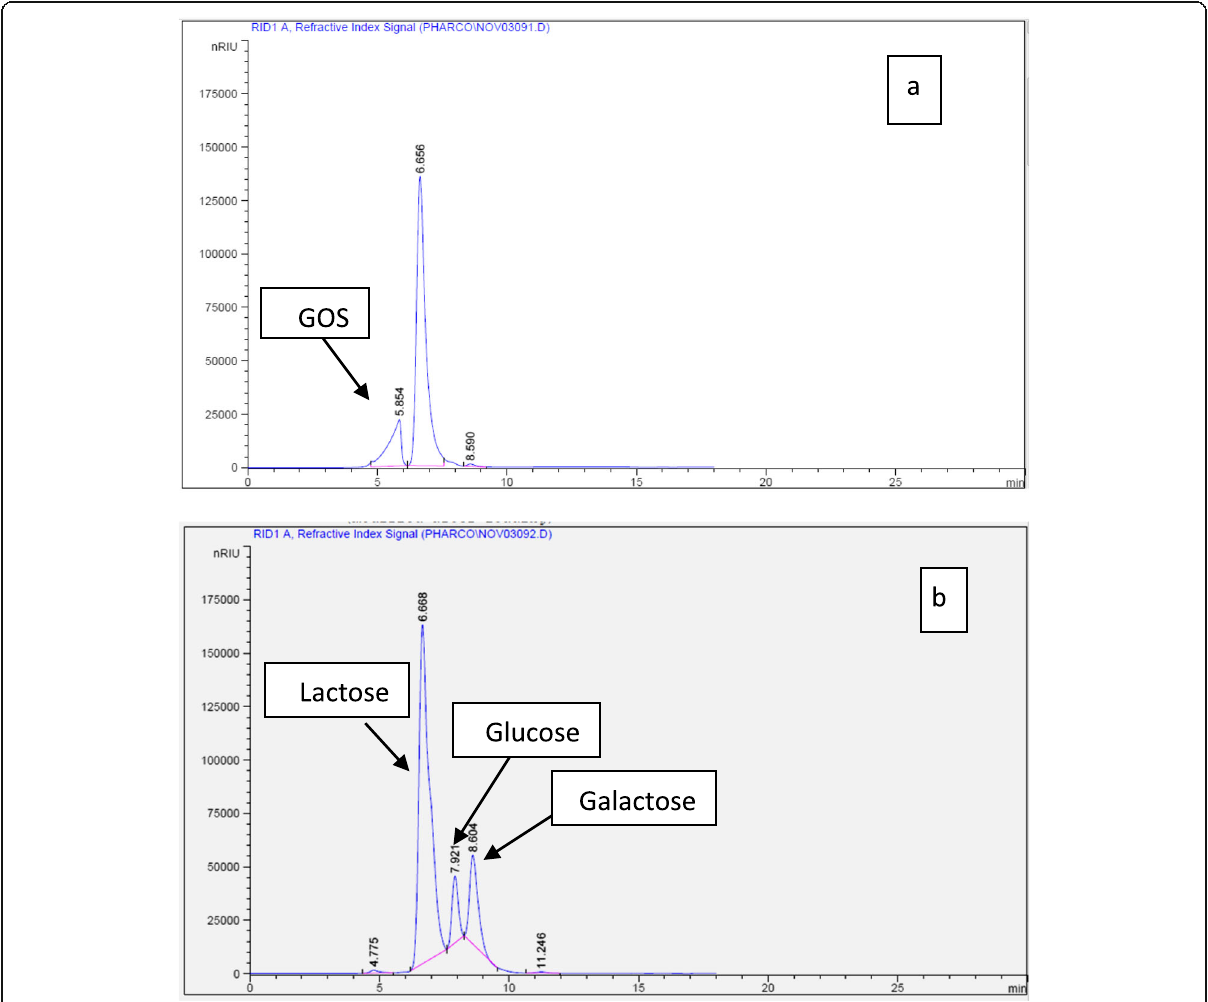
Fig. 5 HPLC Profile of the end product resulting from hydrolysis of D -lactose with β -galactosidase. a After 12 h of reaction. b After 24 h of